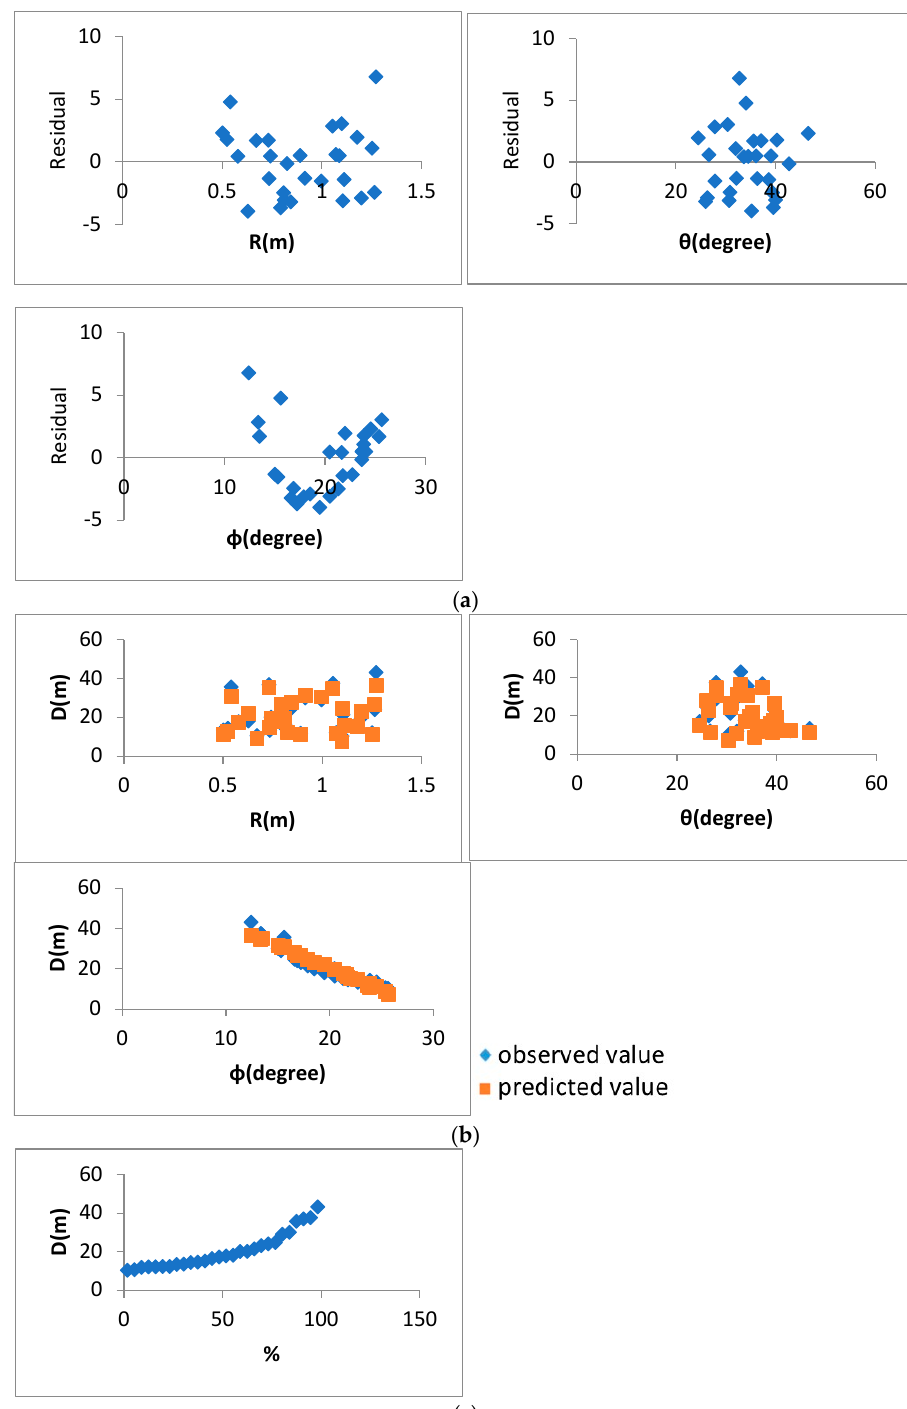
Figure 7. Dimensionless factor relationship of potential LSL area.